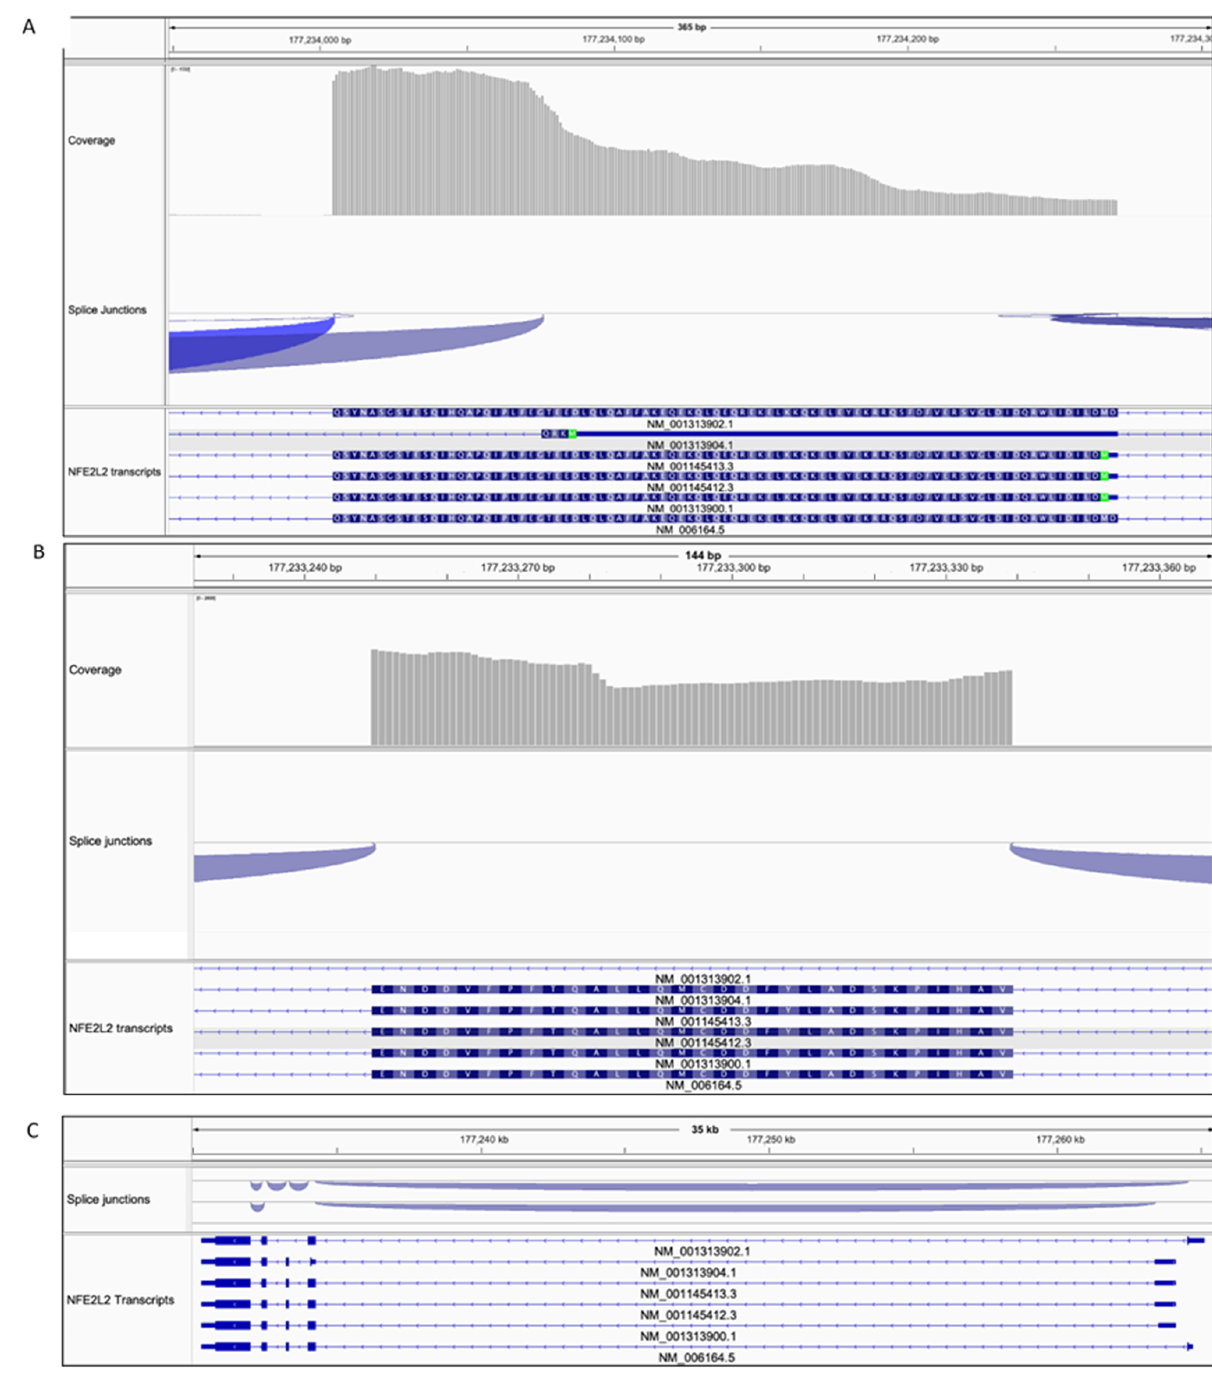
Figure 8. Expression of different NFE2L2 transcripts in A549 cells based on RNA sequencing data. ( A ) Visualization of sequence reads alignments within exon 2. Beginning of the exon 2 is on the right-hand and the end on the left-hand side. Splice junctions are represented by arches. Apart from classical junctions at the beginning and the end of the exon, in a portion of reads the 3’ end of exon 2 was spliced out. These reads have been aligned to the transcript NM_001313904.1 (transcripts references are below each transcript). Transcripts sequence within the exon was translated to the encoded amino acids ( B ) Visualization of sequence reads alignments within exon 3. In the transcript NM_001313902.1 exon 3 is spliced out. ( C ) Visualization of all the transcripts (6) identified in A549 cells. Exon 1 is on the right-hand and exon 5 on the left-hand side. Assembly of RNA-Seq alignments into potential transcripts together with calculation of expression levels for those transcripts were performed with StringTie software [20]. Visualization of the alignments identified transcripts and junctions was performed in IGV software [21].